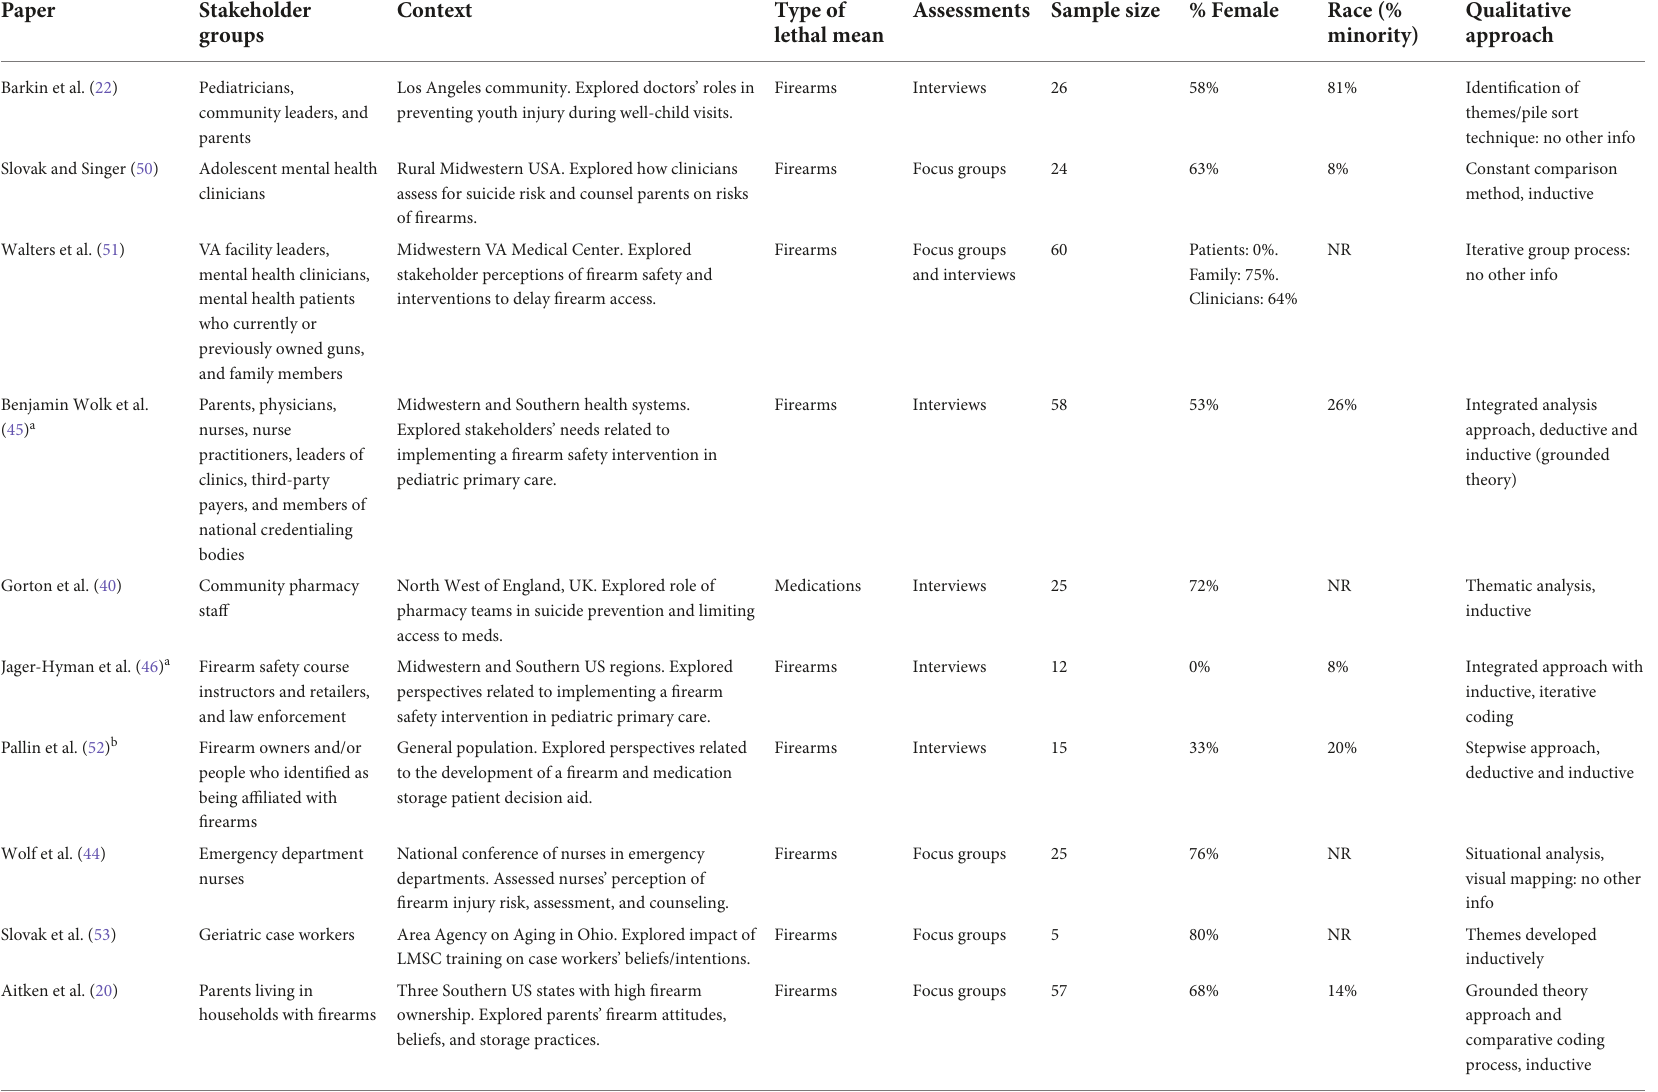
TABLE 1 Study characteristics by year of publication.